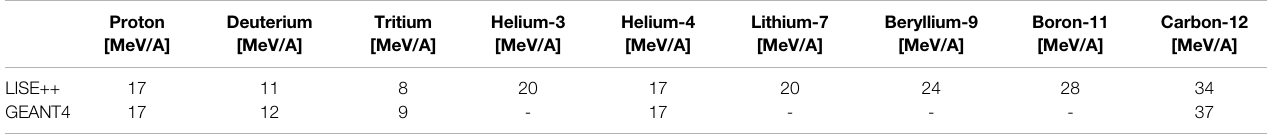
TABLE 2 | Minimum kinetic energies for several isotope types necessary to traverse all the detectors. The values have been calculated with LISE++ toolkit and, for the most representative of the radiation fi eld, also with Geant4. Proton